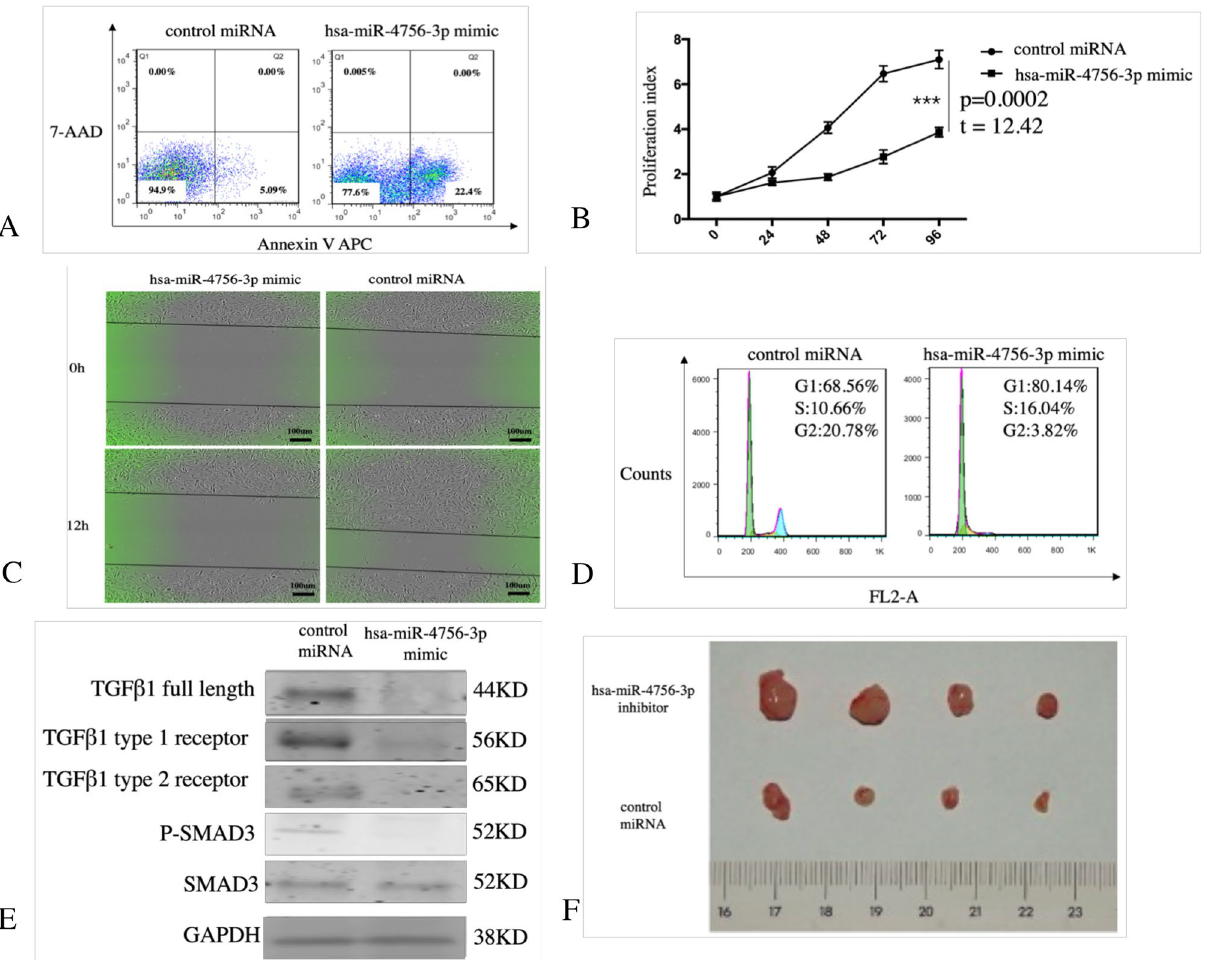
Figure 2. Increased of hsa-miR-4756-3p induced apoptosis, cell cycle arrest and inhibit cell proliferation, migration in vitro . Control miRNA and hsa-miR-4756-3p mimic was transfected in TNBC cell line MDA-MB-231 cells for 48 h, then using ( A ) Annexin V APC/7-AAD double staining to detect the change of cell apoptosis. ( B ) CCK8 to detect cell proliferation change. ( C ) Wound healing assay to assess cell migration change. ( D ) High concentration PI staining to assess cell cycle change. ( E ) MDA-MB-231 cell was transfected with hsa-miR-4756-3p mimic, then TGFβ-1 pathway molecules TGFβ-1, TGFβ-1 type 1 receptor, TGFβ-1 type 2 receptor, SMAD3, p-SMAD3 were detected by western blot. ( F ) MDA-MB-231 cell were injected in mammary gland fat pad of nude mice, then control miRNA and hsa-miR-4756-3p inhibitor were inject in nude mice using DOPC liposomes, after 1 months, mice were sacrificed, and primary tumor diameter were